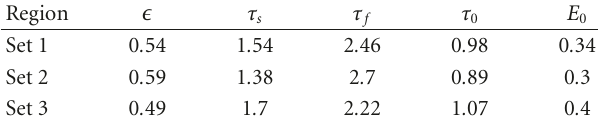
Table 2: The final values of the parameter estimates for the simulated data. α = 0 . 33 and V 0 = 0 . 02 are assumed known.